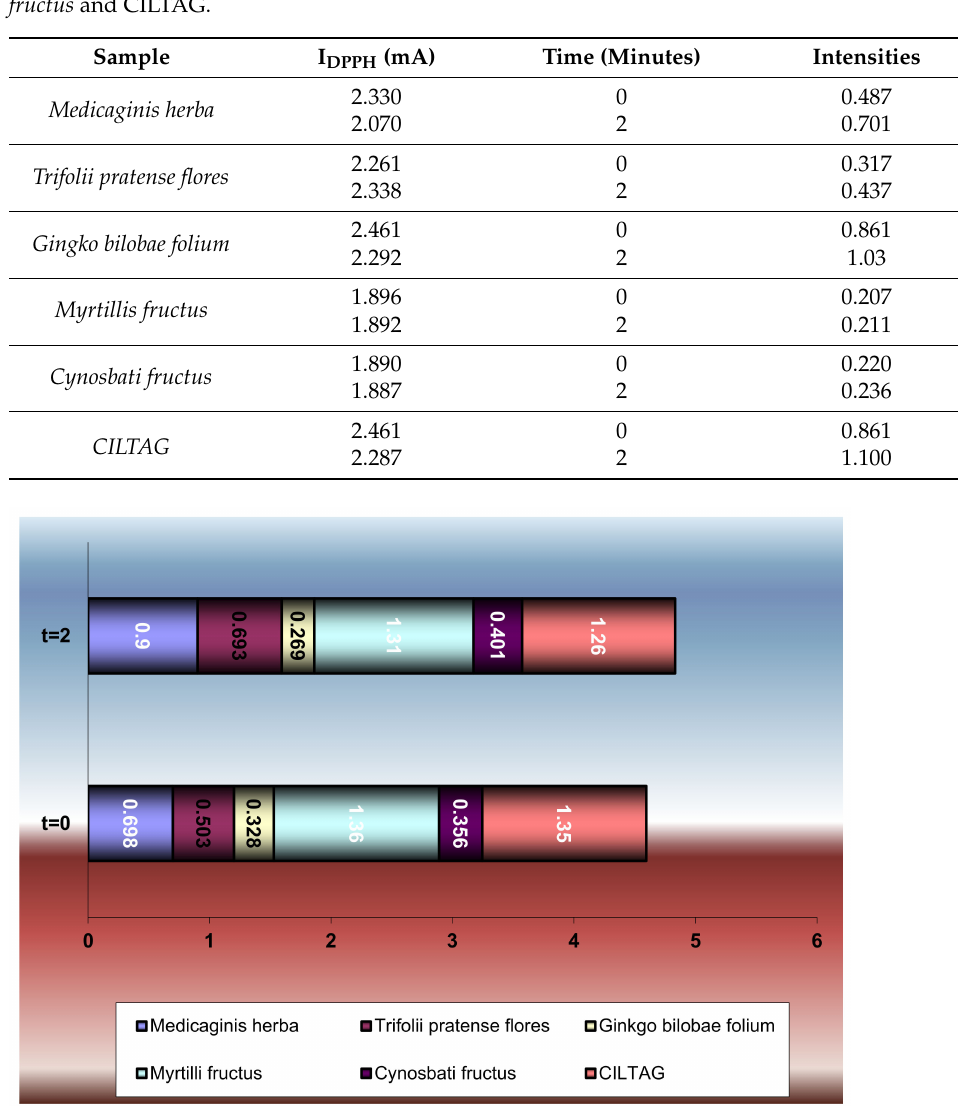
Figure 4. Graphical representation of the antioxidant capacity of hydroalcoholic solutions of Med- icaginis herba, Trifolii pratensae flores, Ginkgo bilobae folium, Myrtilli fructus, and Cynosbati fructus and